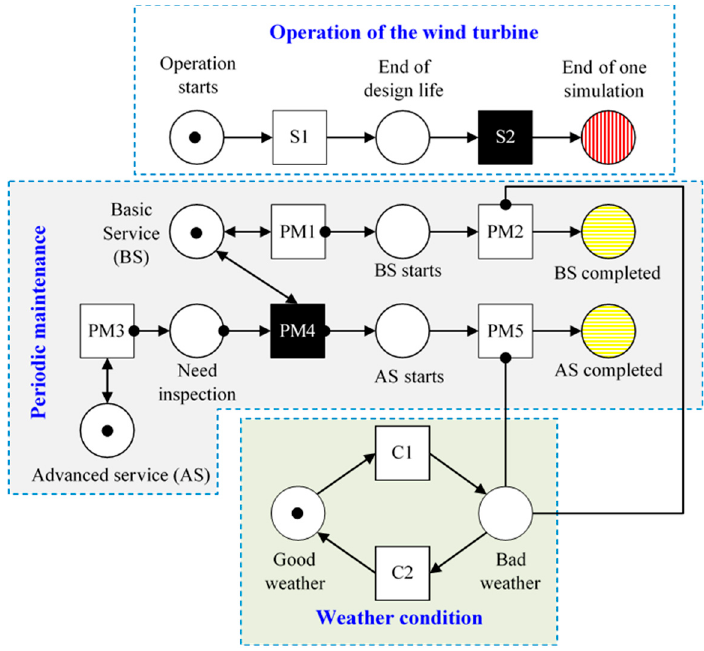
Figure 4. Operation Petri Net (OPN).